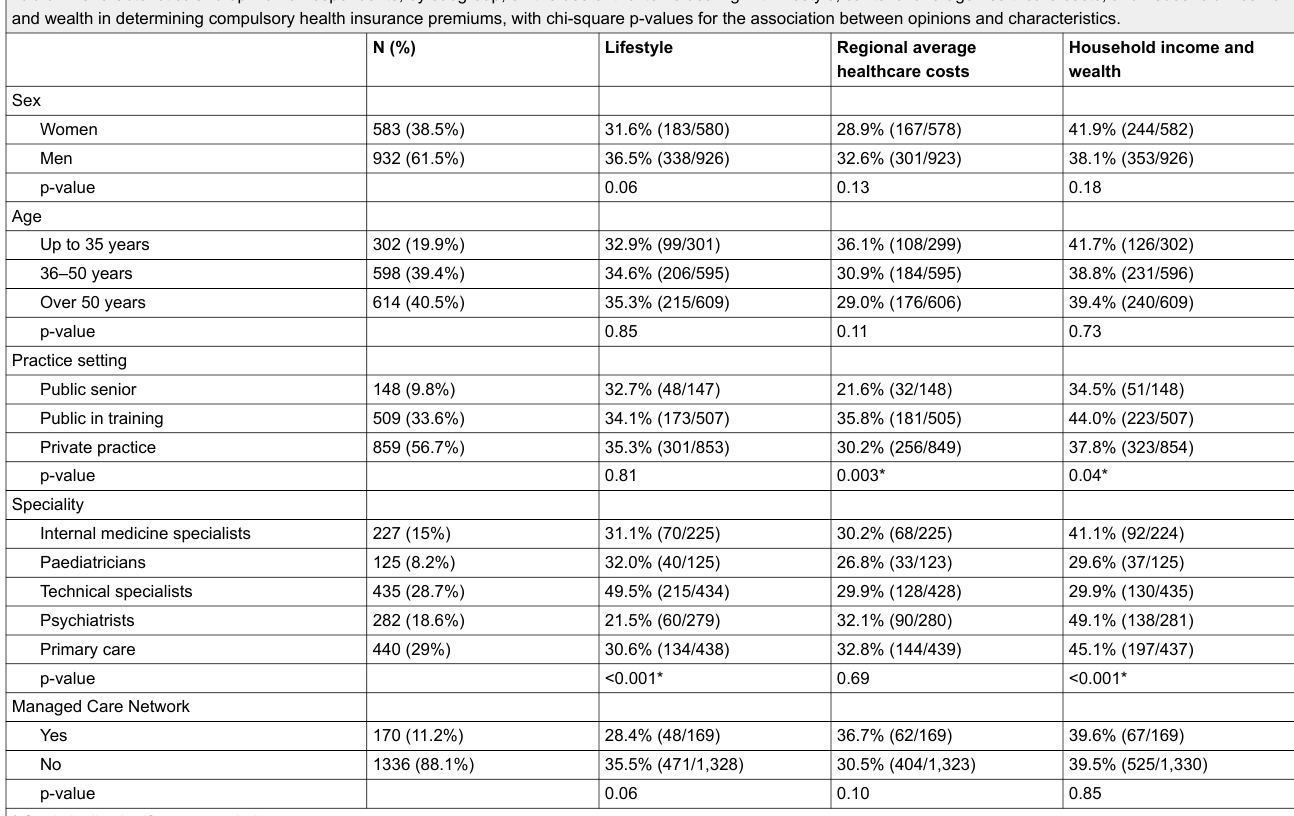
Table 2: Characteristics and opinion of respondents, by subgroup, on the use of the items dealing with lifestyle, cantonal average healthcare costs, and household income and wealth in determining compulsory health insurance premiums, with chi-square p-values for the association between opinions and characteristics. N